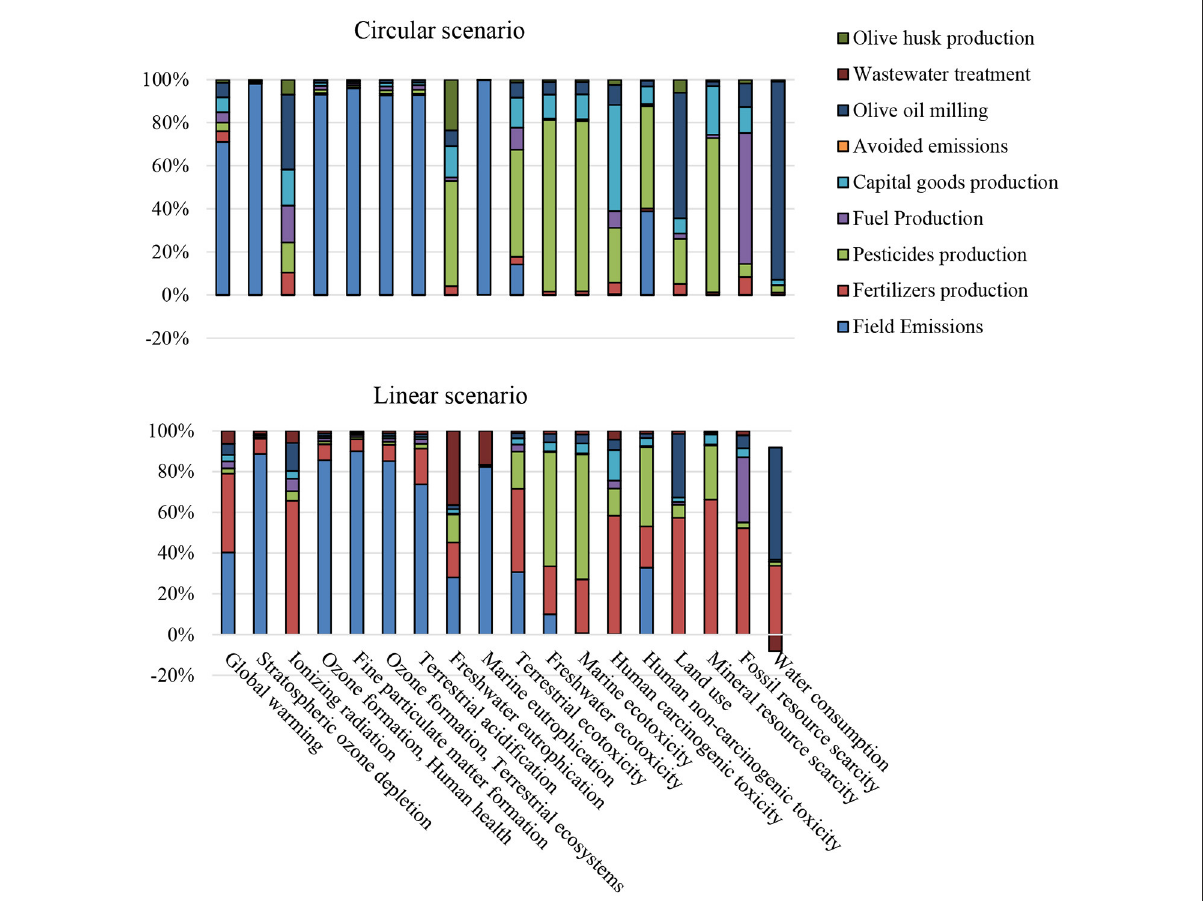
FIGURE2 Contribution analysis of EVO oil production (Source: Authors’ elaboration).